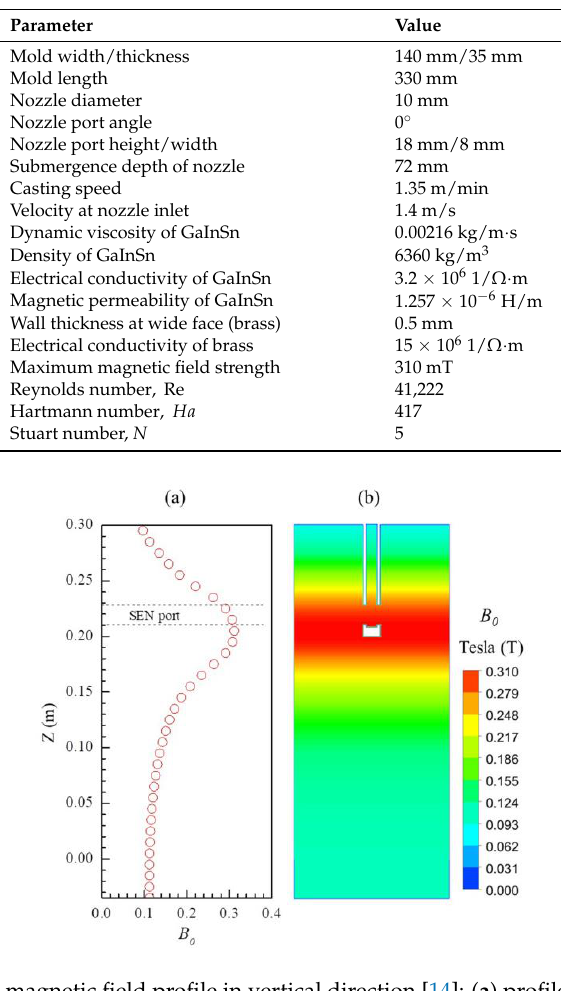
Table 1. Physical properties and operation conditions.